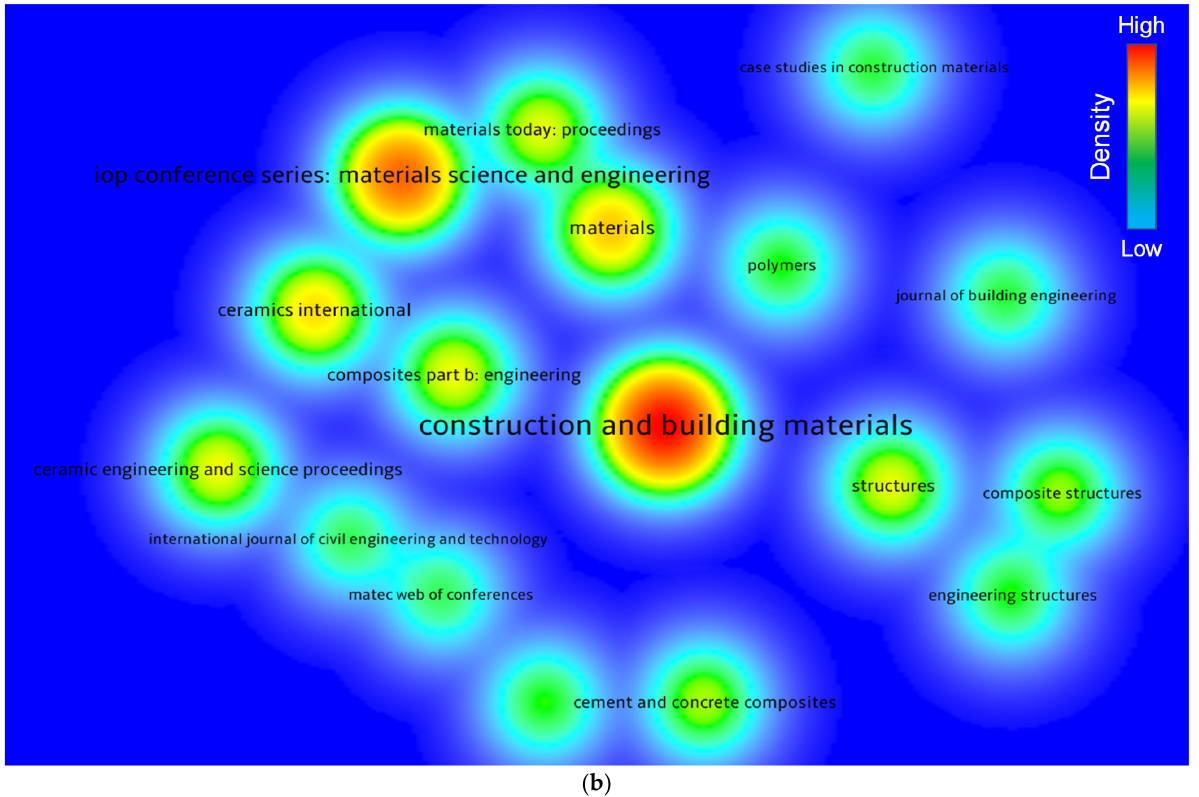
Figure 5. Systematic map of publication outlets: ( a ) network map; ( b ) density map.